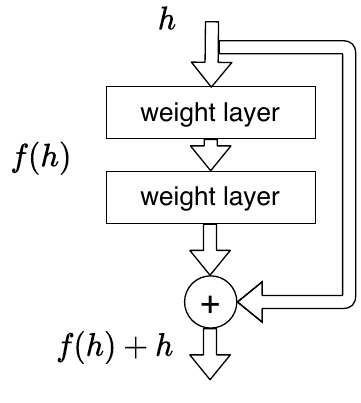
Figure 1. ResNet